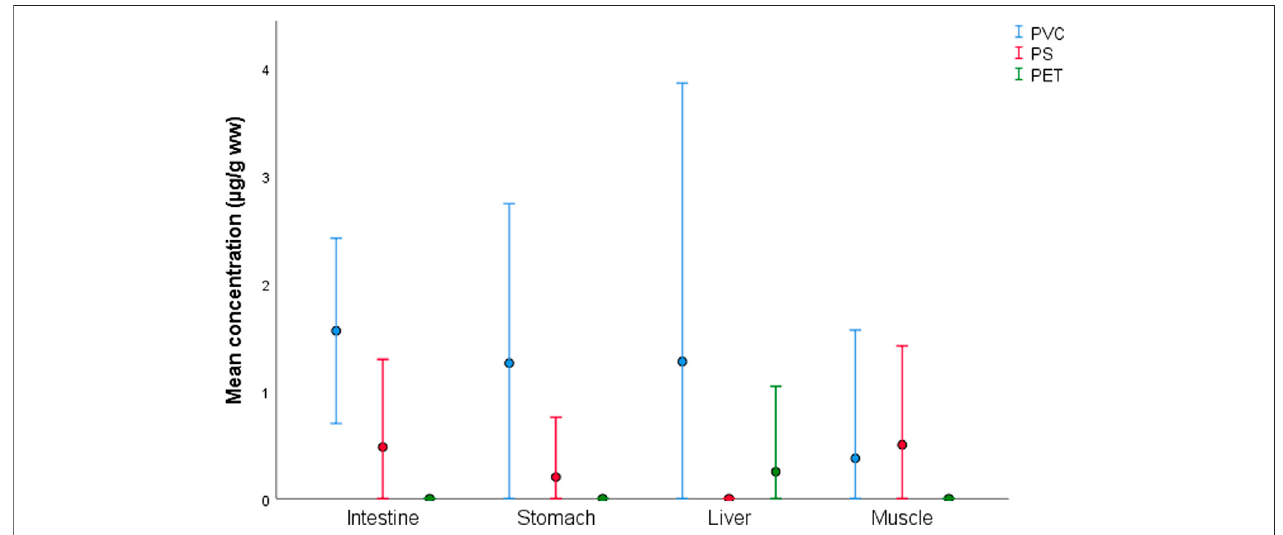
FIGURE 3 | Mean and 95% confidence intervals of concentrations (µg/g ww) of microplastic polymers quanti fi ed in tissues of coastal animals from Sotra in 2018 – 2019.